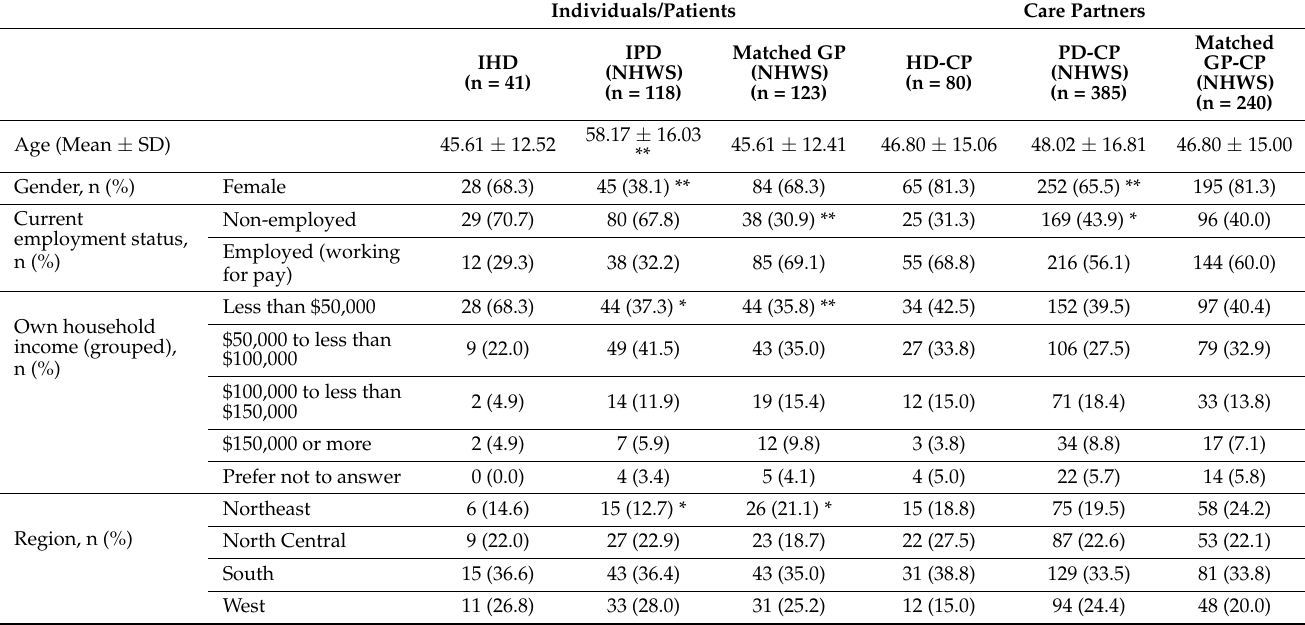
Table 1. Demographic characteristics of all cohorts.